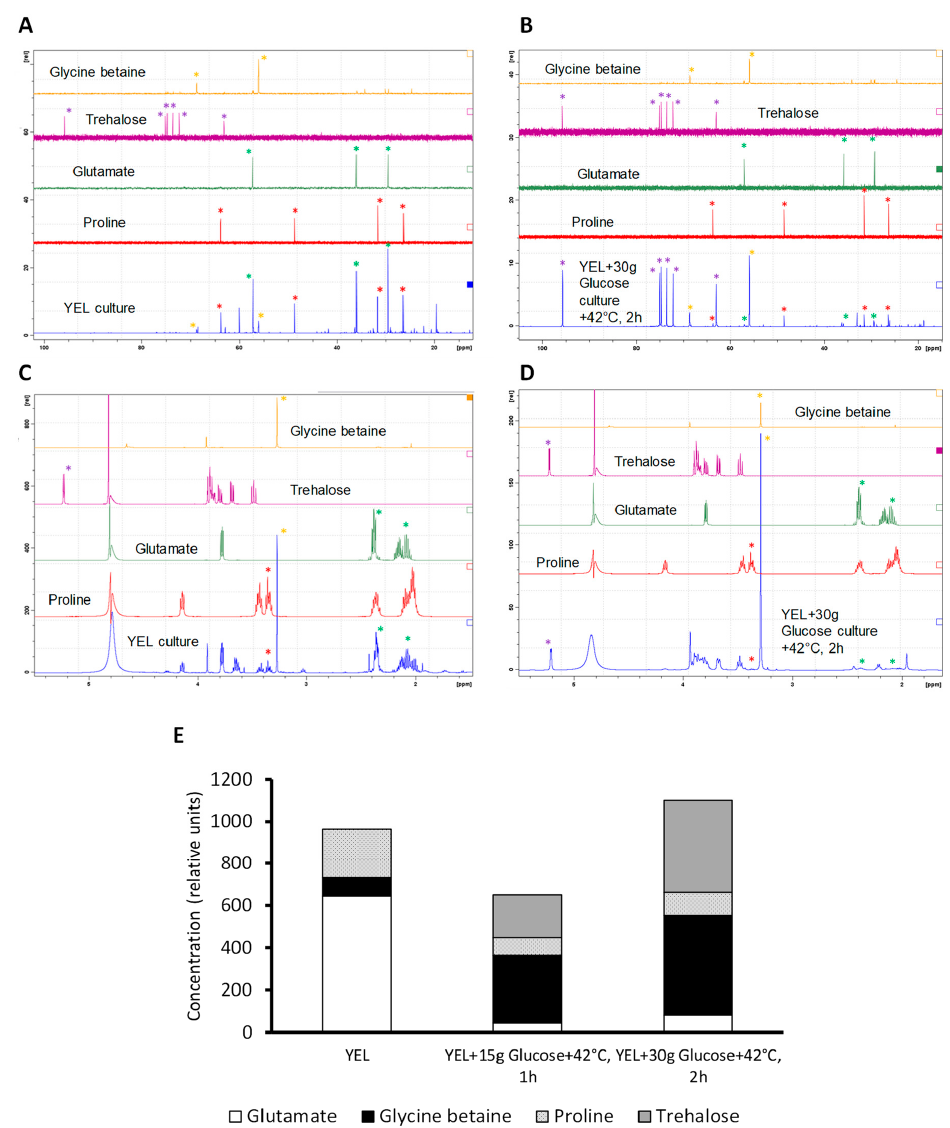
Figure 4. P. freudenreichii compatible solutes is modulated by adaptations. P. freudenreichii CIRM-BIA 129 were cultivated in YEL (YEL + 0 g Glucose + 42 ◦ C, 0 h), in YEL medium containing 15 g · L − 1 of glucose and heat-adapted at 42 ◦ C over 1 h (YEL + 15 g Glucose + 42 ◦ C, 1 h) or YEL medium containing 30 g · L − 1 of glucose and heat-adapted at 42 ◦ C over2 h (YEL + 30 g Glucose + 42 ◦ C, 2 h) until the beginning of the stationary phase. Cytoplasmic extract was made as described in materials and methods. The signals used for the identification ( A , B , C-NMR) and for the quantification ( C , D , H-NMR) of the solutes are shown by colored asterisks. The spectra shown correspond to glycine betaine (yellow), trehalose (purple), glutamate (green), proline (red) and cytoplasmic hydroalcoholic extract (blue). The examples shown corresponds to the control growth conditions (YEL culture, A , C ) and to adapted conditions (YEL + 30 g Glucose + 42 ◦ C, 2 h, B , D ). Spectra corresponding to all conditions are illustrated in the Supplemental Figure. Compatible solutes accumulation is expressed in relative units ( E